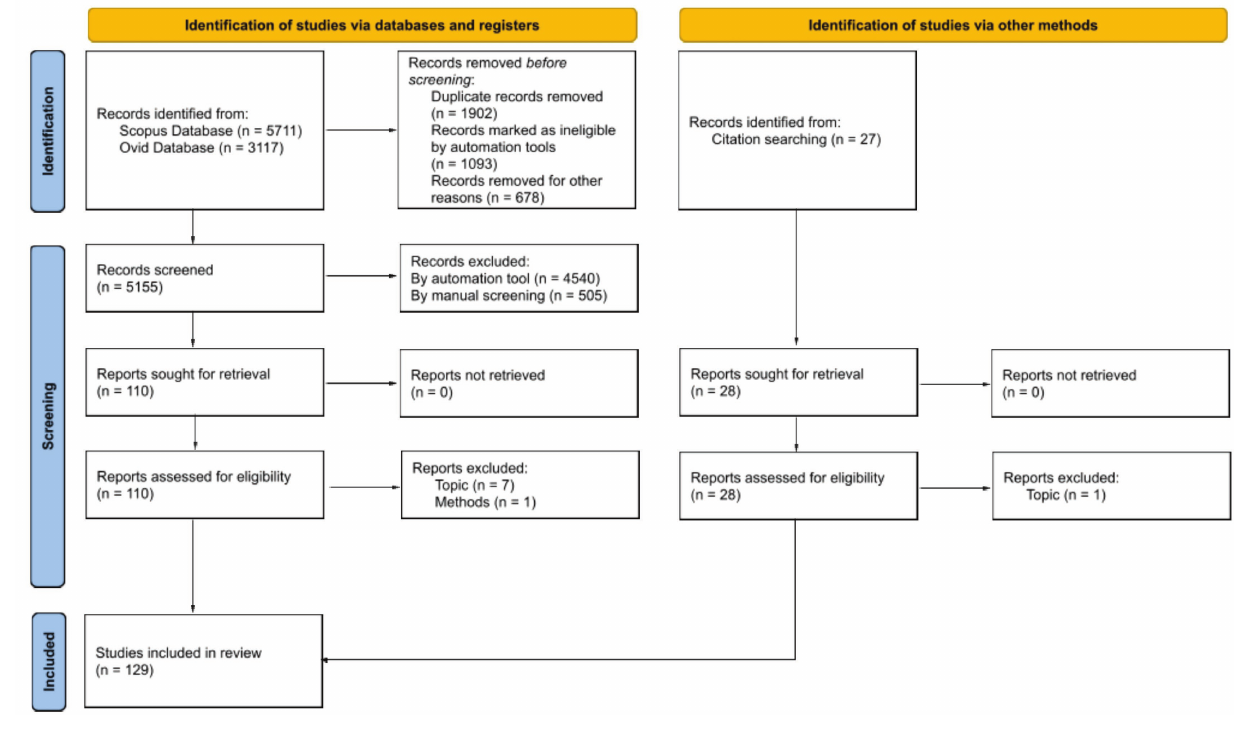
FIGURE 1 | PRISMA flow